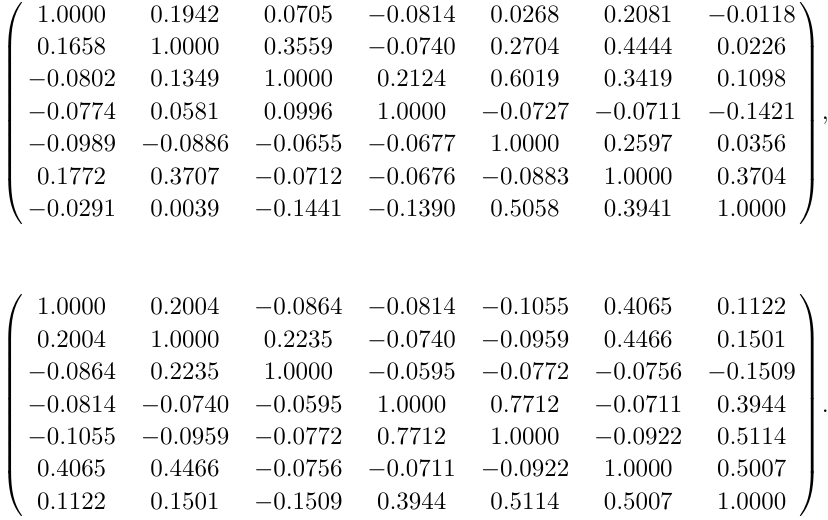
Models 1 and 3 seem to be coherent in indicating the direction of macroeconomic tendencies: 16 out of 21 off-diagonal entries, or 76%, have the same sign. A comparison of models 1 and 2 reveals less coherence: 13 out of 21 off-diagonal entries, or 62%, have the same sign. Finally, these correlations seem to be similar to their counterparts estimated for the models without differentiation: 14 (17) or 67% (81%) of them preserve their sign in the case of models 1 and 2. Again, we see that the distribution of tendency variables seems to be not strongly affected by the diversification mechanism based on industry-specific q . i , s